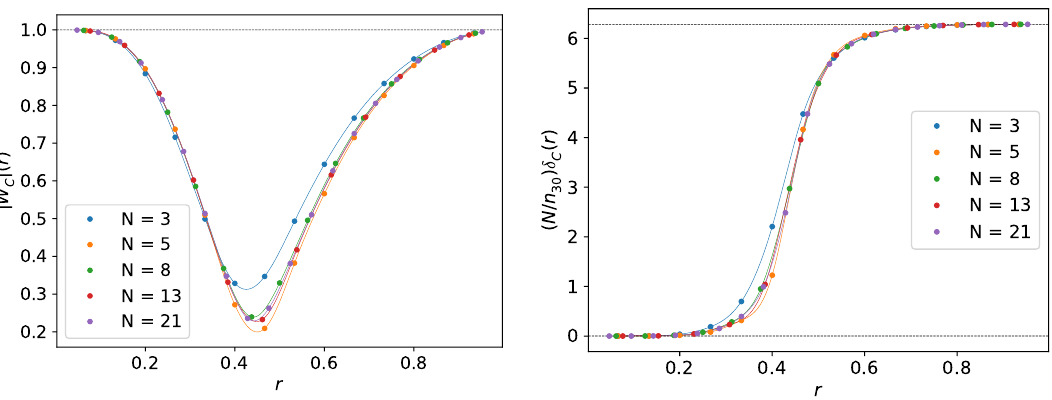
Figure 12. We display the modulus (left) and phase (right), multiplied by N/n 30 , of a square Wilson loop of side r centered at the instanton